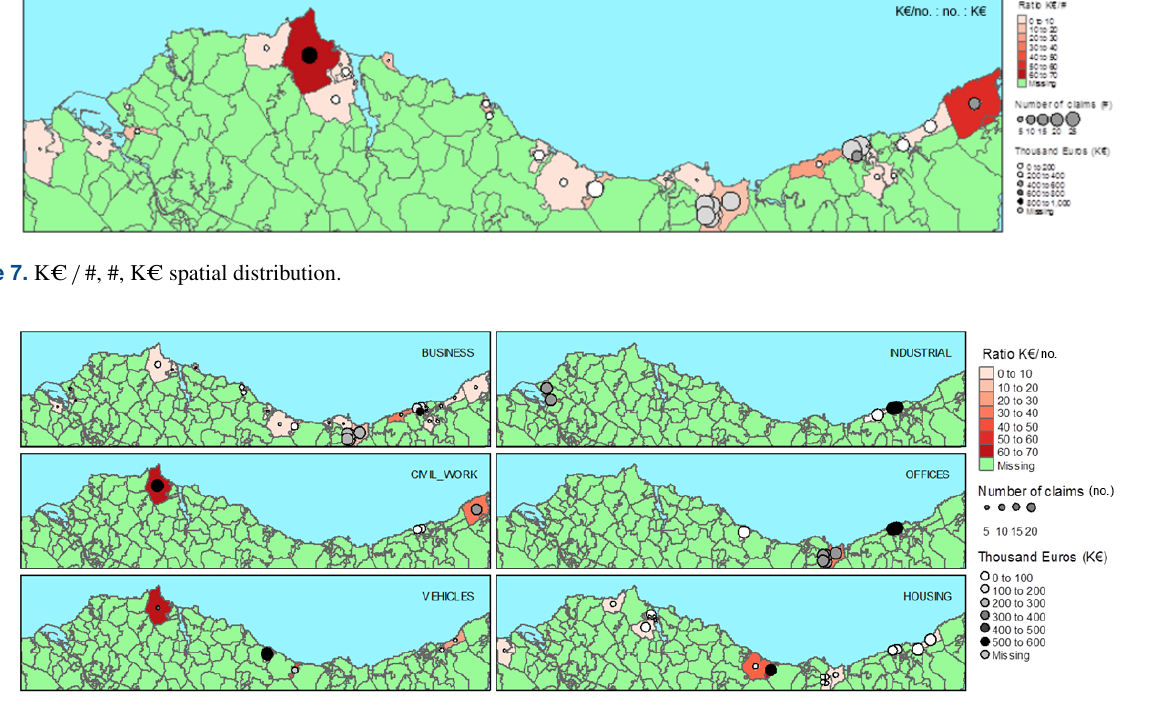
Figure 8. KC / #, #, KC spatial distribution by cause.